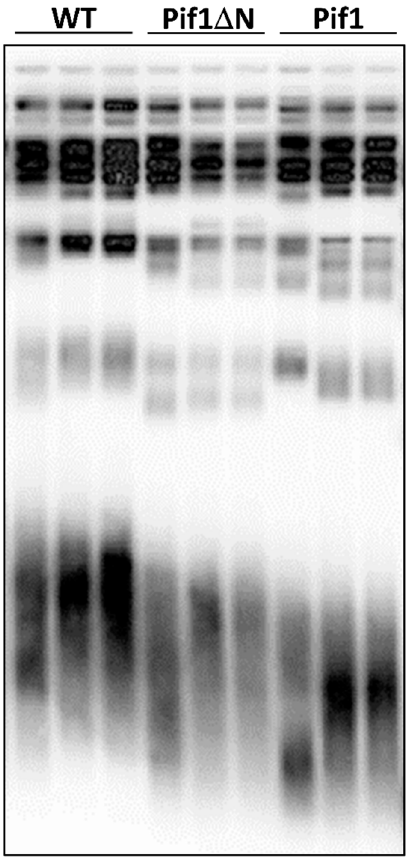
Figure 4. Pif1 ∆ N expression slightly decreases telomere length. A telomere blot of genomic DNA (gDNA) from wild-type cells that were transformed with empty vector (WT) or an expression plasmid for full-length Pif1 or Pif1 ∆ N is shown. Three independent clones from each plasmid transformation were examined after restreaking for ~50 generations.